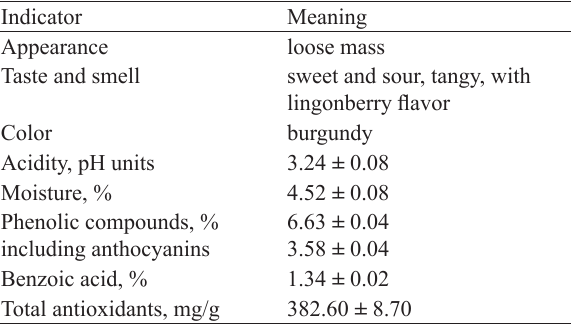
Table 1 Qualitative indicators of dry lingonberry marc extract Indicator Meaning